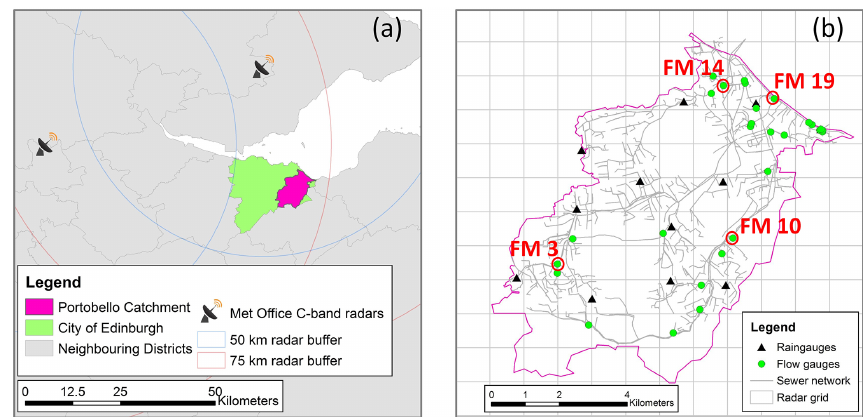
Figure 3. Portobello catchment (a) general location; (b) sensor location, sewer network and radar grid over the catchment. Flow gauges FM 3, 10, 14 and 19 (the circled round markers in (b) , respectively located at the up-, mid- and downstream parts of the catchment) are particularly selected for visual inspection in Sect.